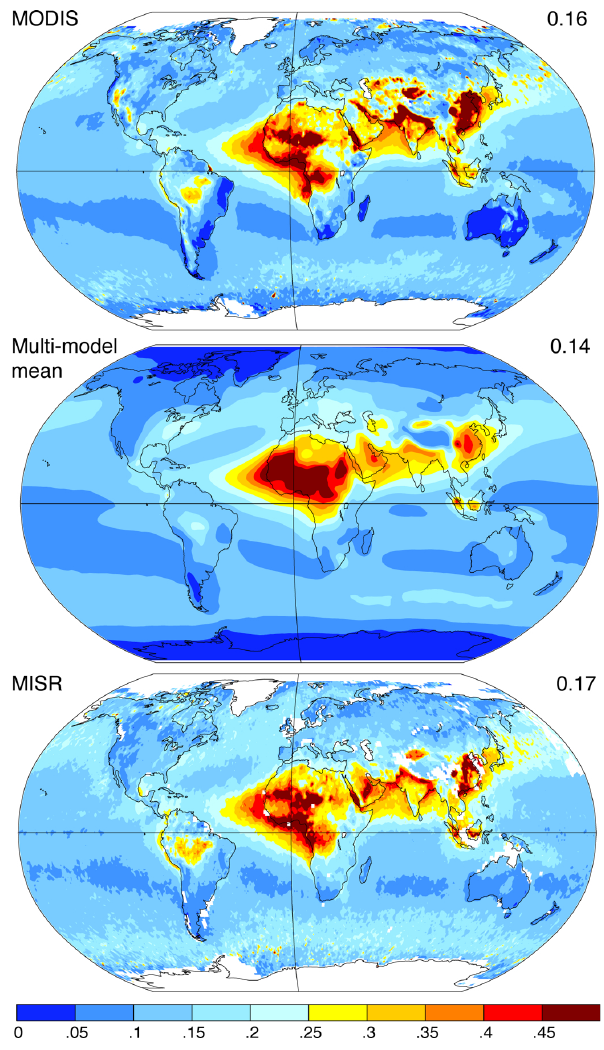
Fig. 1. Annual average aerosol optical depth (550nm) seen by the MODIS (top) and MISR (bottom) instruments and the ACCMIP multi-model mean (10 models) for the simulations of conditions representative of ∼ 2000 (center). Global mean values are given in the upper right corner of each map. White indicates no data in the satellite measurements. Clear-sky model values are used when available (see Table 2).